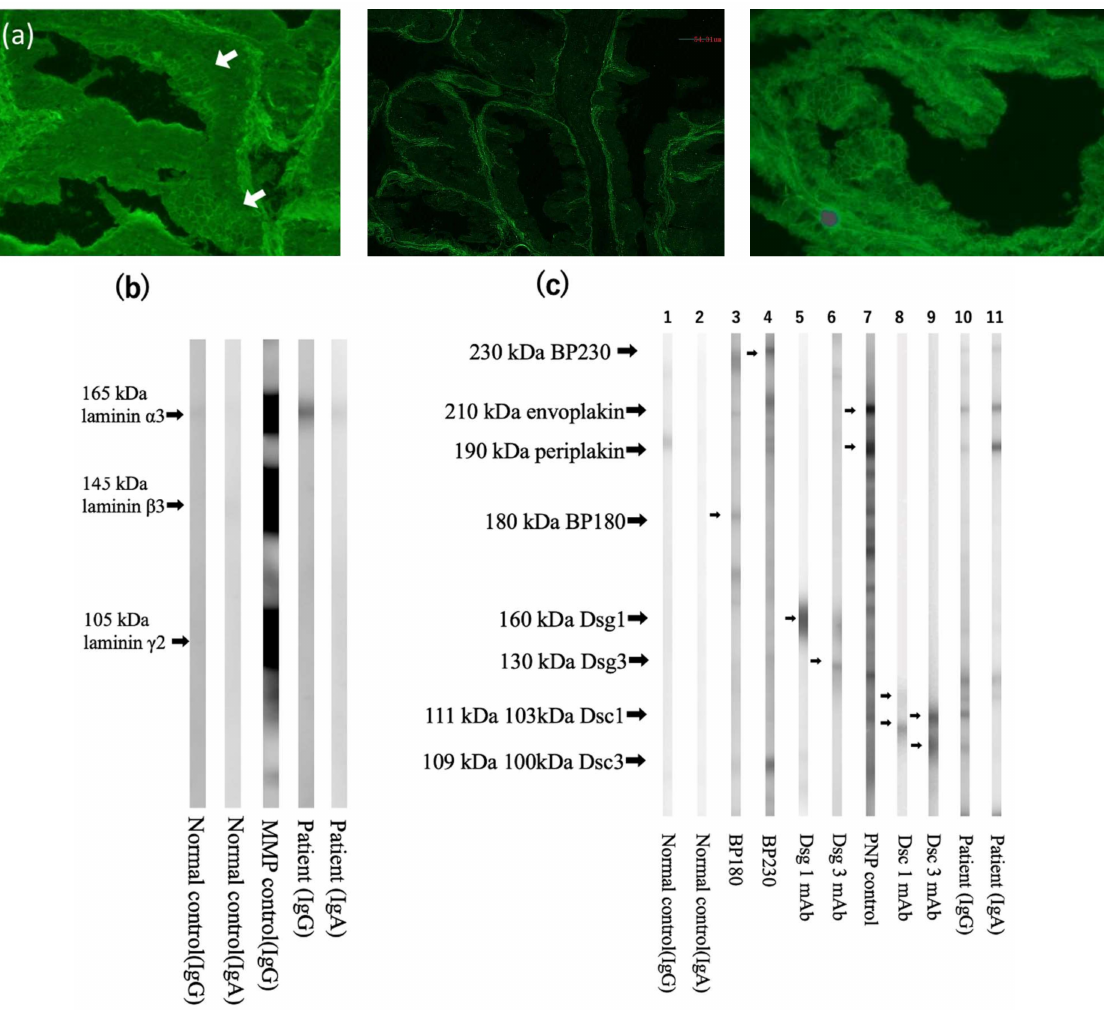
Figure 2. Immuno-serological findings ( a ) Left: indirect immunofluorescence using rat bladder showed IgG reactivity with cell surfaces of the transitional epithelia in this patient (white arrows, serum dilution × 40). Center: negative control. Right: positive control. ( b ) The results of immunoblot- ting using recombinant proteins of laminin-332. Normal control serum showed no specific reactivity for both IgG and IgA (lane 1, 2). IgG antibodies of control anti-laminin-332 MMP serum reacted with the 165 kDa laminin- α 3, 145 kDa laminin- β 3, and 105 kDa laminin- γ 2 (lane 3). IgG and IgA antibodies in our case’s serum reacted with the 165 kDa laminin- α 3 (lane 4,5). ( c ) The results of immunoblotting using normal human epidermal extract. Normal control serum showed no specific reactivity (lanes 1,2). Control bullous pemphigoid (BP) sera reacted with the 180 kDa BP180 and 230 kDa BP230 (lanes 3,4). Specific monoclonal antibodies (mAbs) reacted with 160 kDa desmoglein 1 (Dsg1) (lane 5), the 130 kDa Dsg3 (lane 6), the 111 kDa and 103 kDa desmocollin 1 (Dsc1) (lane 8), and the 109 kDa and 100 kDa Dsc3 (lane 9). Control PNP serum reacted with the 210 kDa envoplakin and the 190 kDa periplakin (lane 7). IgG and IgA antibodies in our patient’s serum reacted with envoplakin and periplakin (lanes 10,11). IgG antibodies in our case’s serum also reacted with Dsc3 (lane